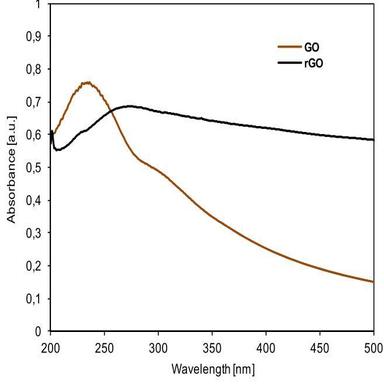
UV–Vis absorption spectra for graphene oxide in solution with the maximum at 232 nm and for the reduced graphene oxide in solution with the maximum at 270 nm.